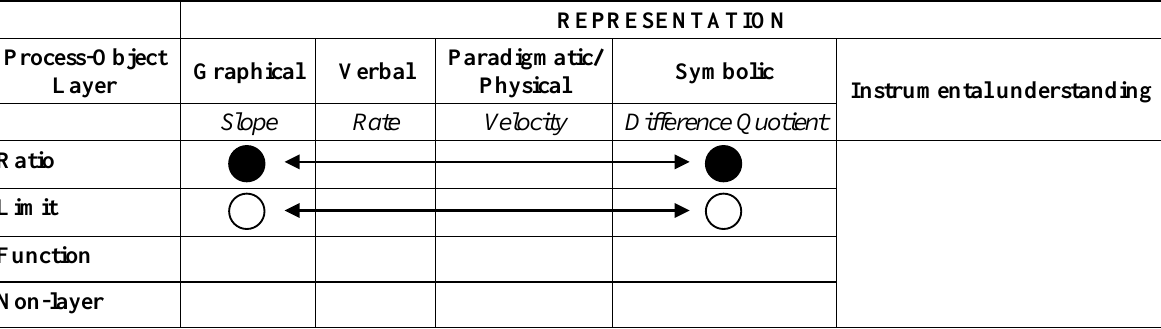
Figure 3: Further analysis of Nompilo’s